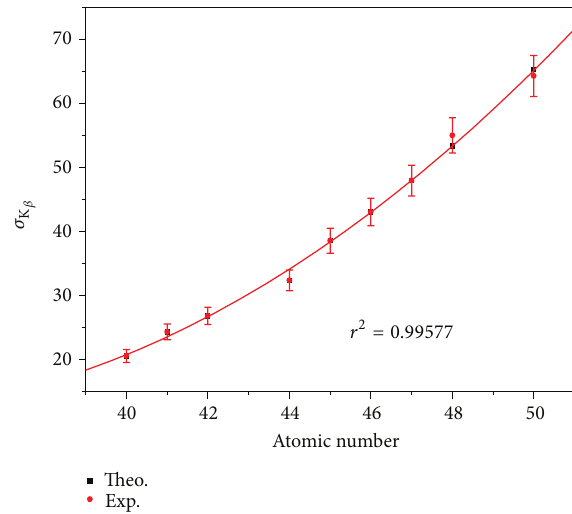
Figure 4: The variation in 𝜎 function of atomic number.